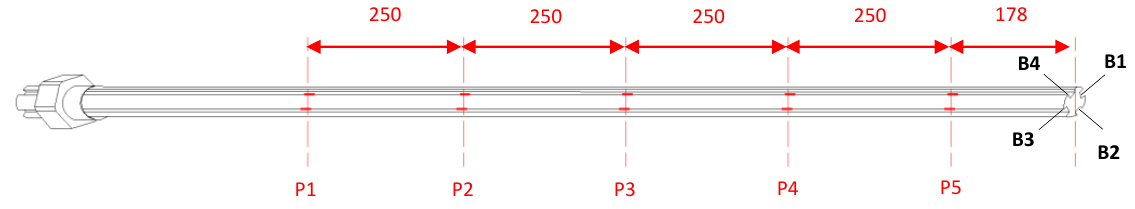
Figure 2. Scheme of the developed instrumented rock bolt.